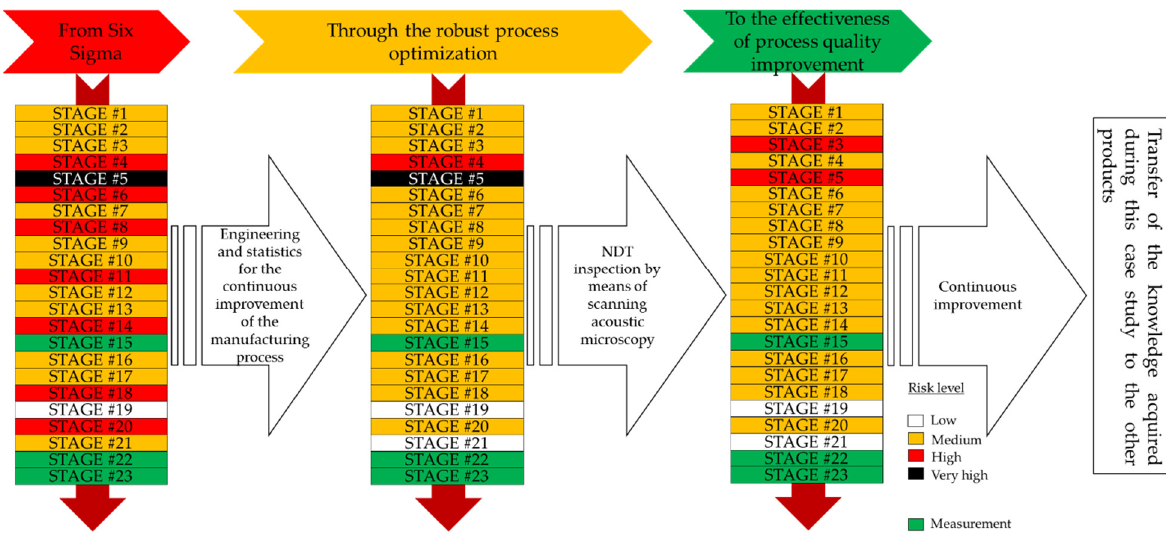
Figure 9. The risk level mitigation during the robust process optimization.